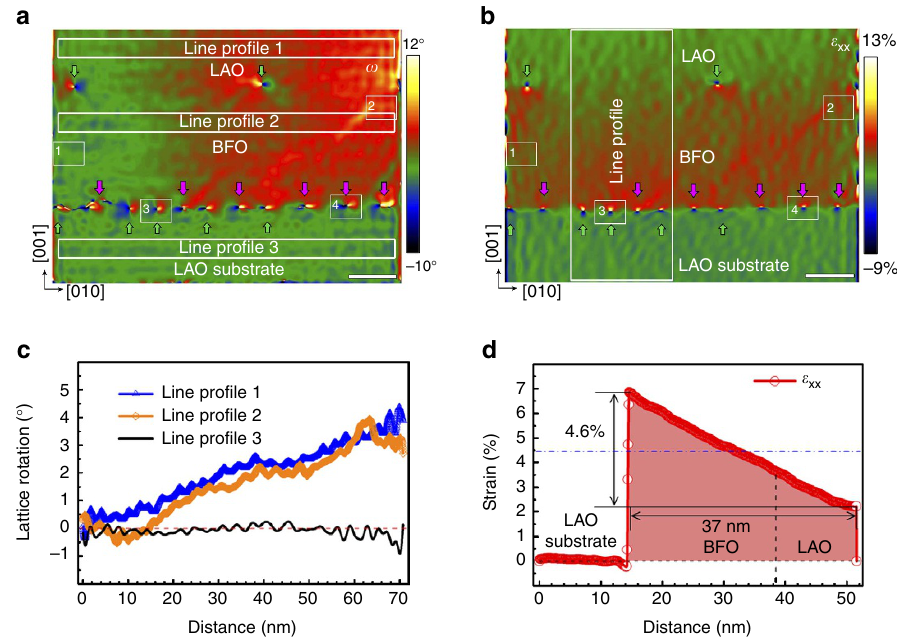
Figure 2 | Lattice rotation ( x ) and in-plane strain ( e xx ) maps of the two-layer LaAlO 3 /BiFeO 3 /LaAlO 3 (001) nanostructures. ( a ) 2D lattice rotation ( o ) and ( b ) in-plane strain ( e xx ) maps via GPA. LaAlO 3 substrate is chosen as the reference lattice. Scale bars in a and b are 10nm. Note the obvious contrast at the dislocation cores and the continuous change of lattice rotation in both LaAlO 3 and BiFeO 3 layers across the in-plane direction. Boxes labelled as 1, 2, 3 and 4 are four typical areas correspond to that in Fig. 1a. Profiles corresponding to the three marked lines in a are visualized in c . The continuous increase of lattice rotation in both BiFeO 3 and LaAlO 3 nanostructures can be clearly seen, which changes from 0 (cid:2) (left) to B 4 (cid:2) (right). Note the transfer of lattice rotation from the BiFeO 3 to the top LaAlO 3 nanostructure. Also note the continuous decrease of in-plane strain in both LaAlO 3 and BiFeO 3 nanostructures across the out-of-plane direction. A white boxed area labelled as line profile in b is chosen as a visualization line-profile shown in d . A blue dotted line in d indicates the nominal mismatch magnitude (4.5%) for BiFeO 3 /LaAlO 3 (001). The strain gradient of e xx is estimated by the slopes of the curve in d , which is well above 10 6 m (cid:2) 1 order.